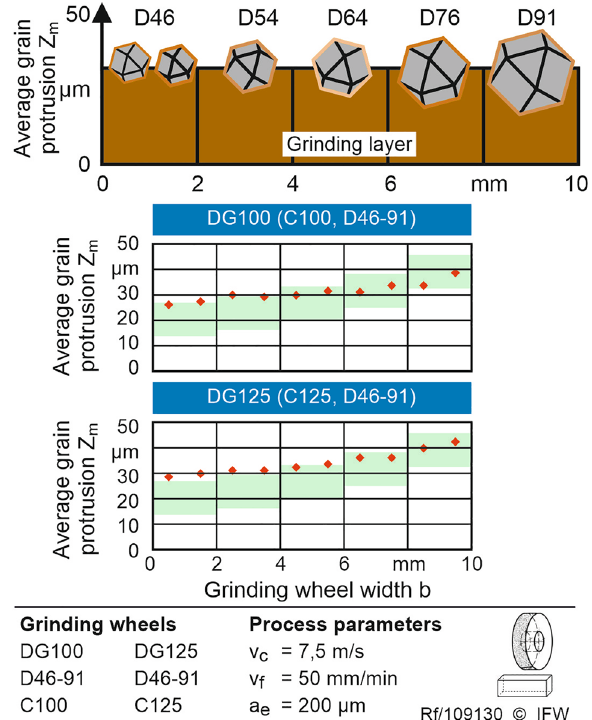
Fig. 11 Course of average grain protrusion for grinding wheels with grain size